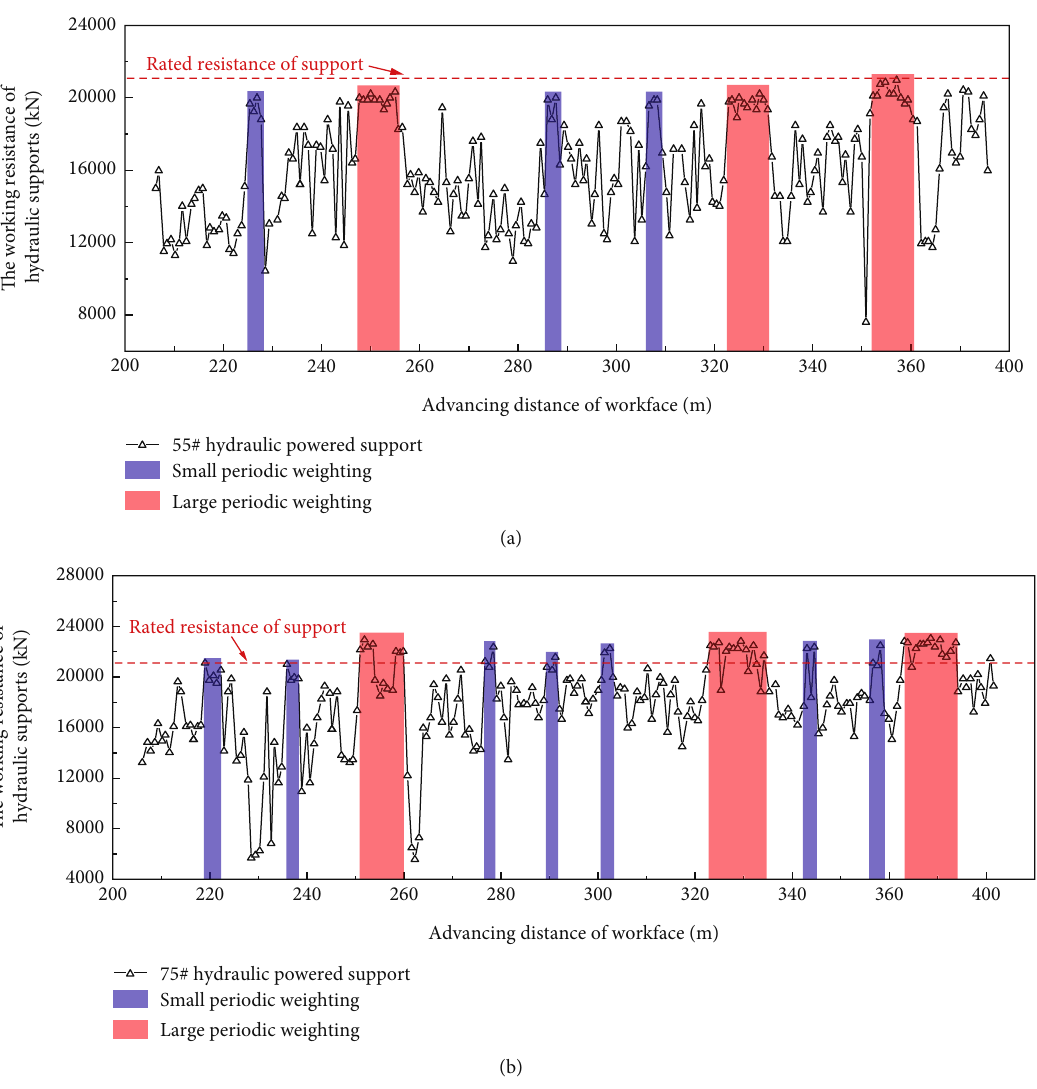
Figure 3: Working resistance of the hydraulic powered support. (a) 55# hydraulic powered support. (b) 75# hydraulic powered support. Table 2: Stress-strain relationship of double-yield materials. Strain